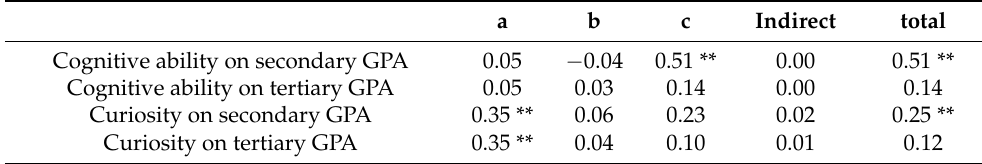
Table 2. Estimated standardized latent regression weights and indirect and total